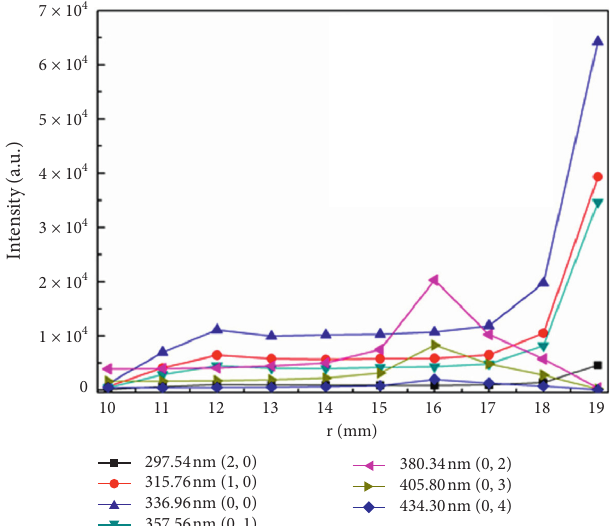
Figure 11: The trends of seven representative spectral lines of the SPS of the nitrogen